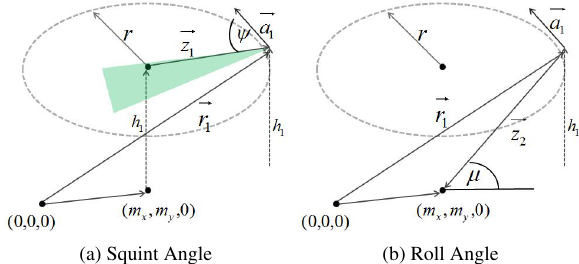
Figure 3: Circular SAR Geometry - Calculation of the instanta- neous beam focus center Figure 4: Calculation of optimal roll and squint